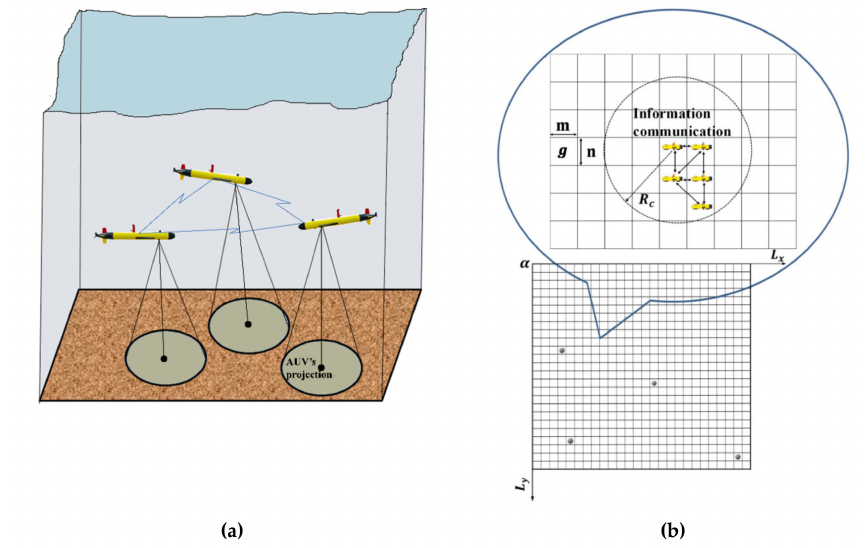
Figure 1. ( a ) Autonomous underwater vehicle’s (AUV) projection on the region; ( b ) search area